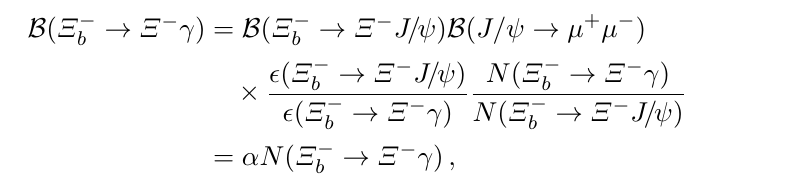
The branching fraction is determined